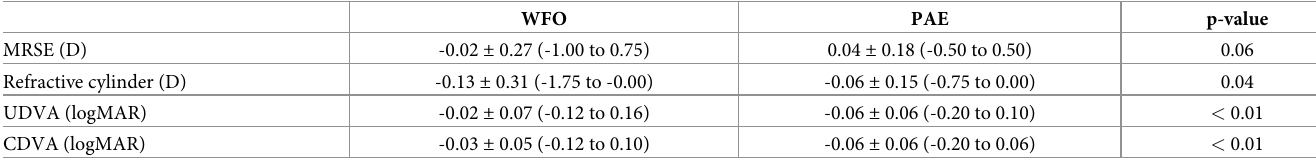
Table 2. Summary postoperative refractive and visual acuity